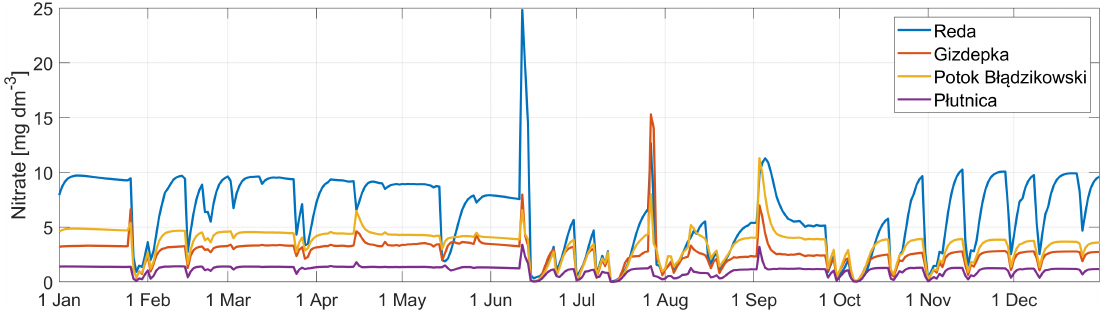
Figure 6. Average concentration of nitrates in rivers entering the Puck Bay provided by SWAT (mg dm − 3